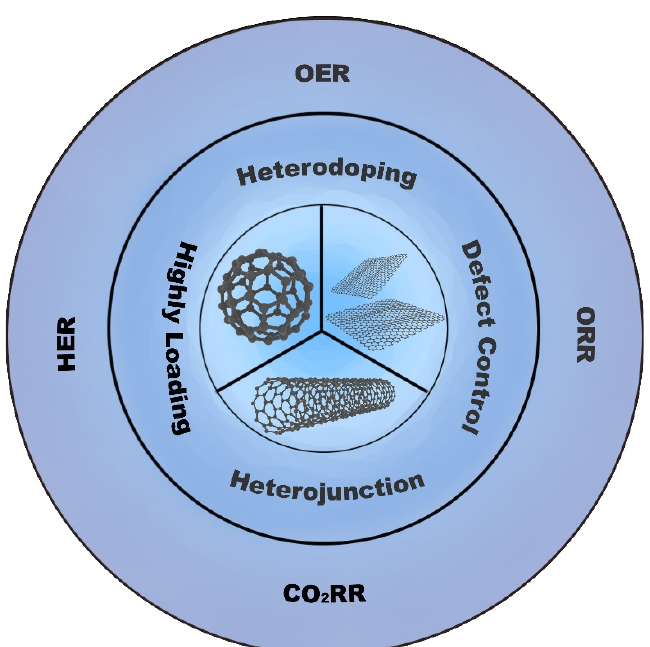
Figure 1. Graphite-derived materials and modification approaches used to develop advanced elec- trocatalysts for electrochemical energy storage and conversion systems based on the four redox re- actions depicted in the